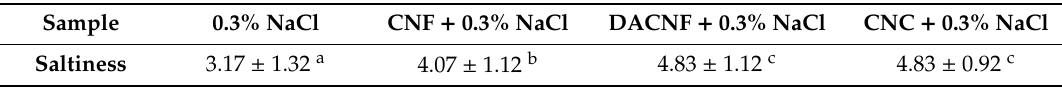
Table 3. The salty sensory evaluation of chitin nanomaterials / 0.3% NaCl